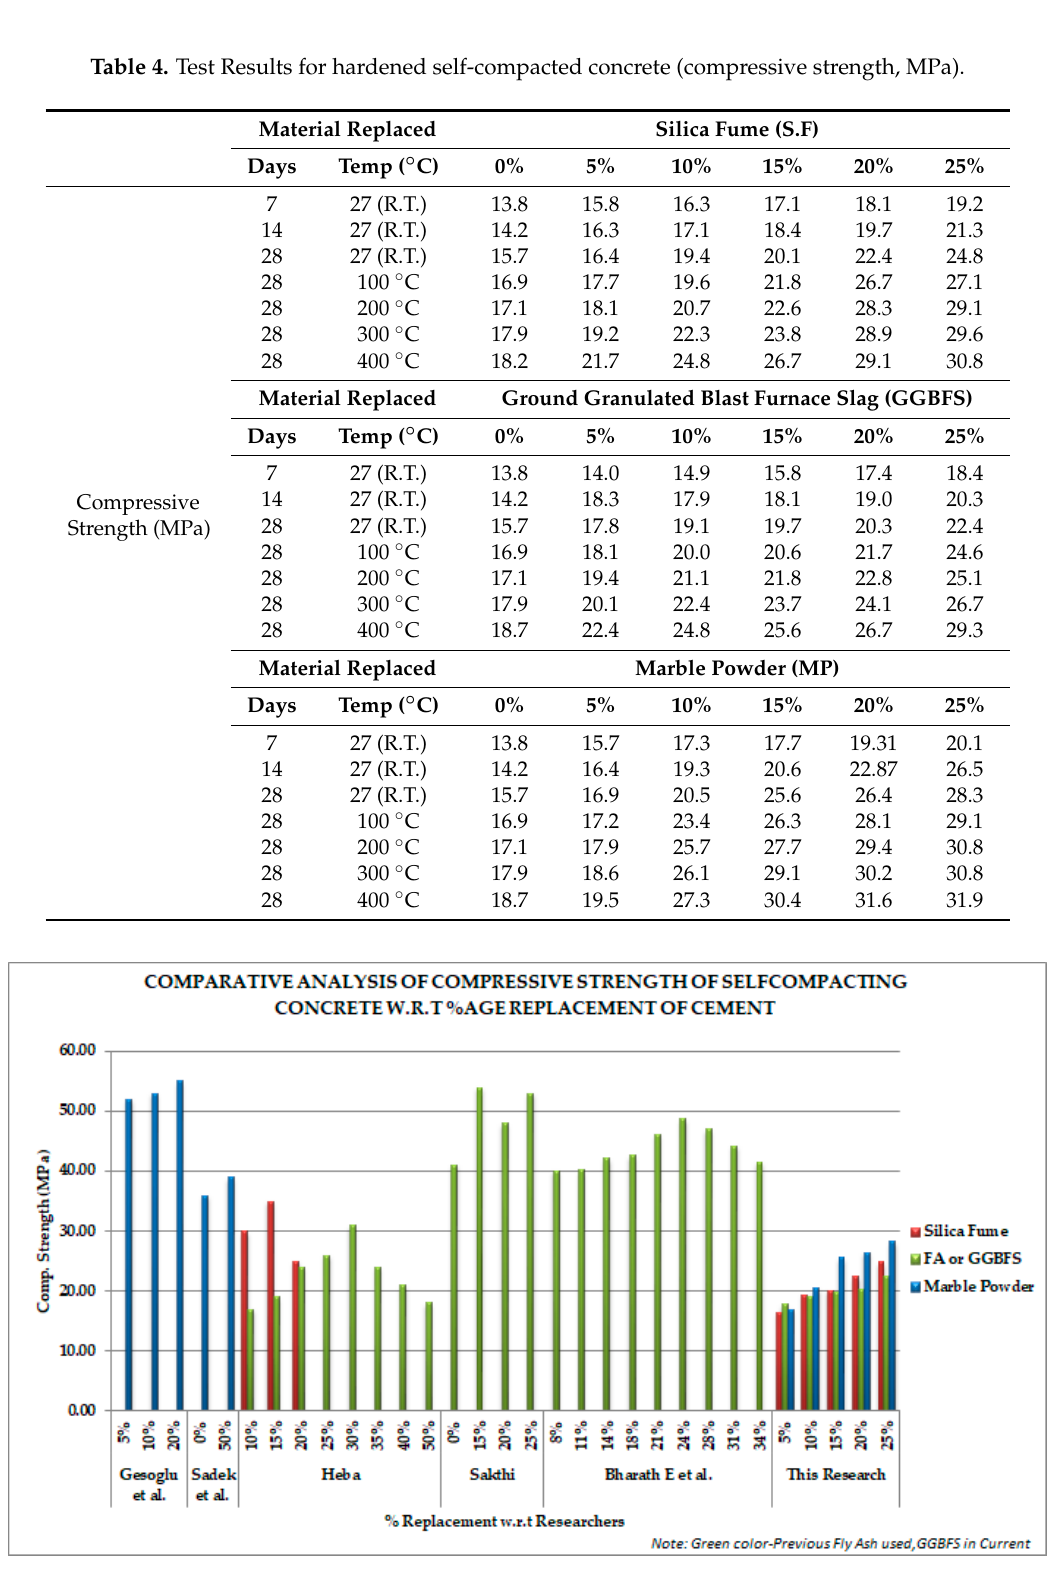
Figure 3. Comparative compressive strength trend with respect to cement replacement of previous studies (Gesoglu [7], Sadek [9], Heba [8], Sakthi [42] and Bharath [5]).